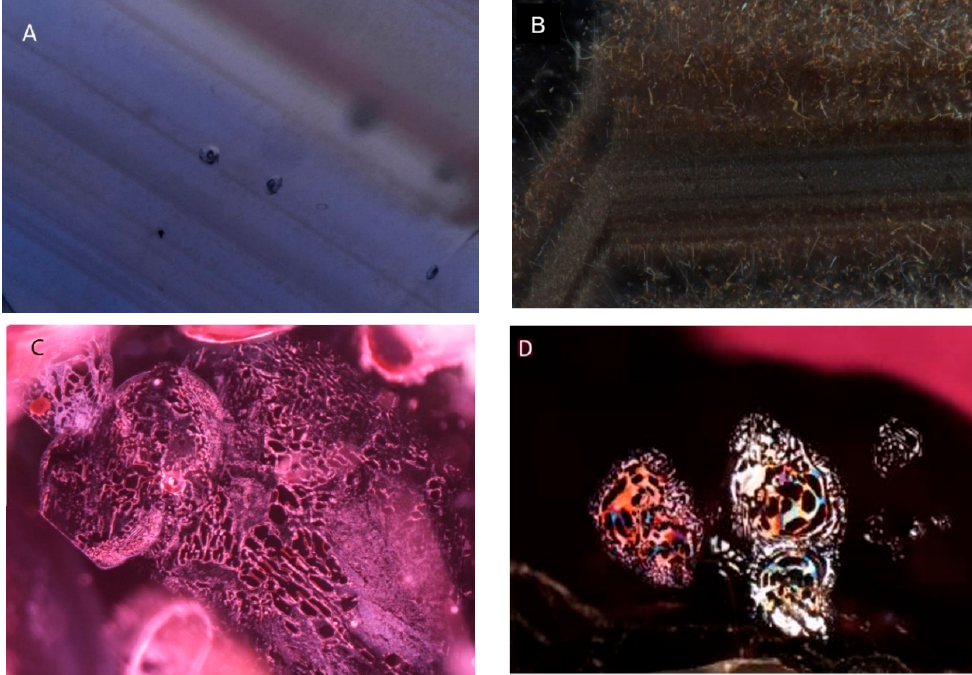
Figure 2. Photomicrographs of inclusions in Thai / Cambodian ( A , B ) blue sapphires representing ( A ) glassy melt inclusions and ( B ) oriented rutile inclusions in angular bands and ( C , D ) rubies representing ( C ) a glass melt inclusion which has burst out into the corundum host and ( D ) inclusions with geometric, partially healed decrepitation haloes. Thai / Cambodian rubies are characterized by melt-filled decrepitation haloes around melt inclusions, whereas the blue sapphires are characterized by melt inclusions and planar to hexagonally arranged bands of rutile silk. Photomicrographs by ( A , B ) Jonathan Muyal and ( C , D ) Aaron C. Palke. Fields of view: ( A ) 1.26 mm ( B ) 1.26 mm, ( C ) 1.26 mm, and ( D ) 1.58 mm.